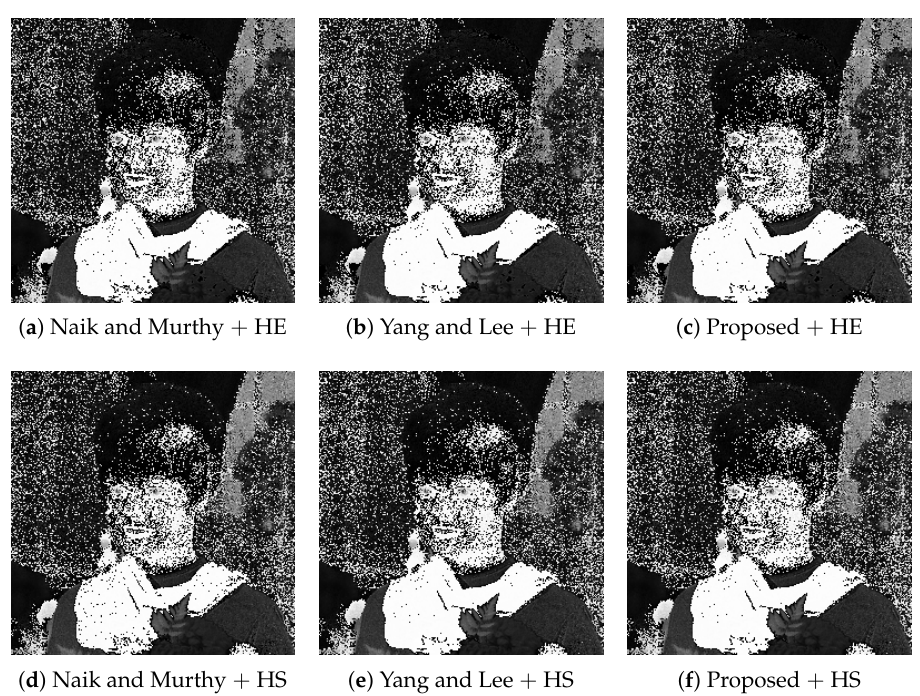
Figure 9. Hue images computed from the corresponding color images in Figure 6: the top row ( a – c ) shows the luminance images with histogram equalization (HE) for computing target intensities, and the bottom row ( d – f ) shows that with histogram specification (HS).